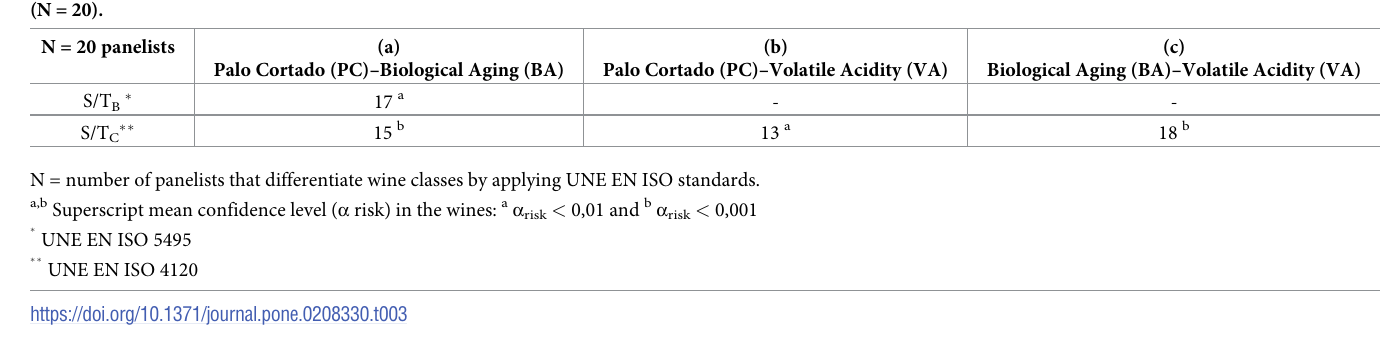
studies have confirmed that LAB esterases are responsible for ethyl lactate production during MFL [45, 46]. Ethyl lactate levels achieved in the S/T (PC) (329 mg/L) are almost 11 times B higher than the control values, much higher than the threshold perception (150 mg/L), which contributes to butterscotch and buttery odour descriptors [14]. Regarding the metabolites of biological aging, we can see in Table 4 that the levels of glyc- erin in S/T (PC) are significantly higher than those in S/T (BA) and S/T lys (BA). Glycerin B B B decreases only 13% over one year of biological aging, which corresponds to a very low con- sumption rate when compared with S/T (BA) and S/T lys (BA), which show decreases of B B 42% and 50%, respectively. It is likely that the relative high glycerin levels in S/T (PC) could B partially justify the perception of greater volume in the mouth that provides as a differential attribute for the identification of “palo cortado”. Acetaldehyde showed the same behaviour, whose production by “flor” velum yeast is very low in S/T (PC) (71 mg/L) compared to that of S/T (BA) and S/T lys (BA), which present B B B 102 mg/L and 129 mg/L, respectively. This clearly indicates that the development of “flor” velum yeast and/or their metabolism could be affected by LAB growth and MLF. In this sense,